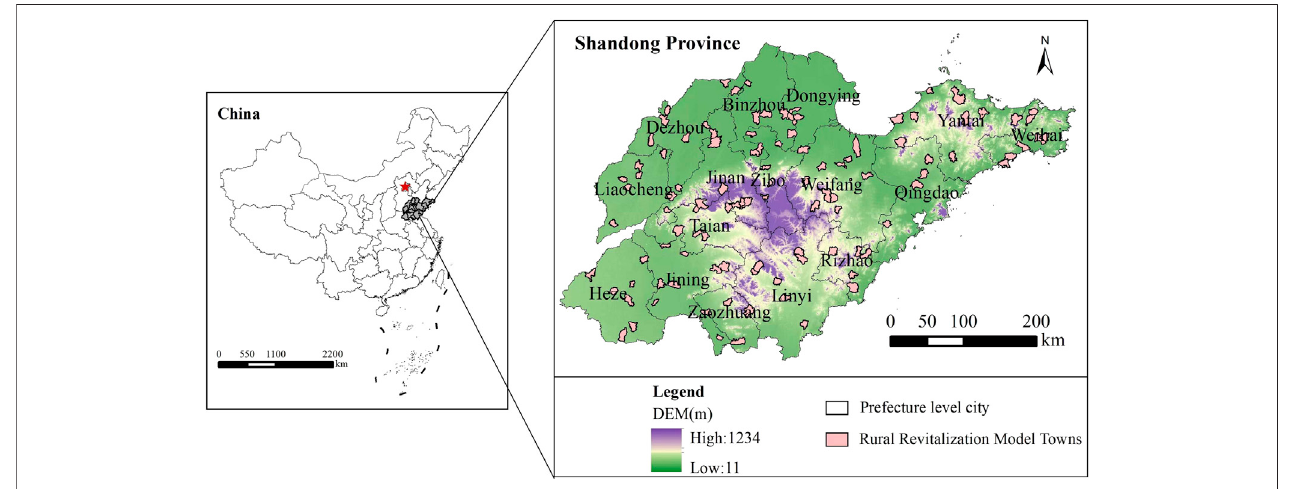
FIGURE 2 | Distribution of rural revitalization model